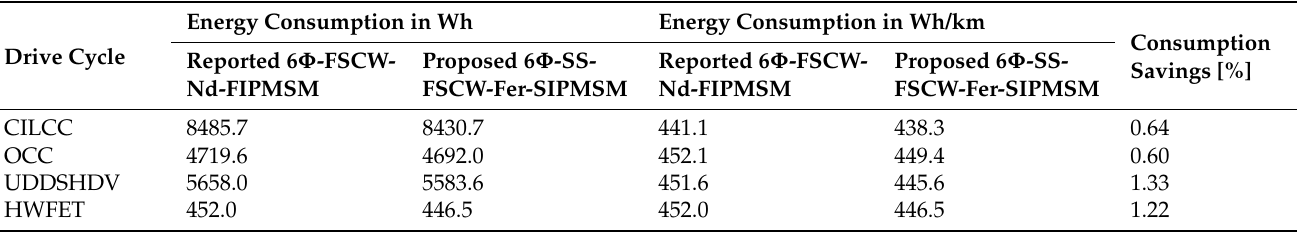
Table 11. Energy consumption of the reported and proposed motor with a 3-speed gearbox under 4 drive cycles.